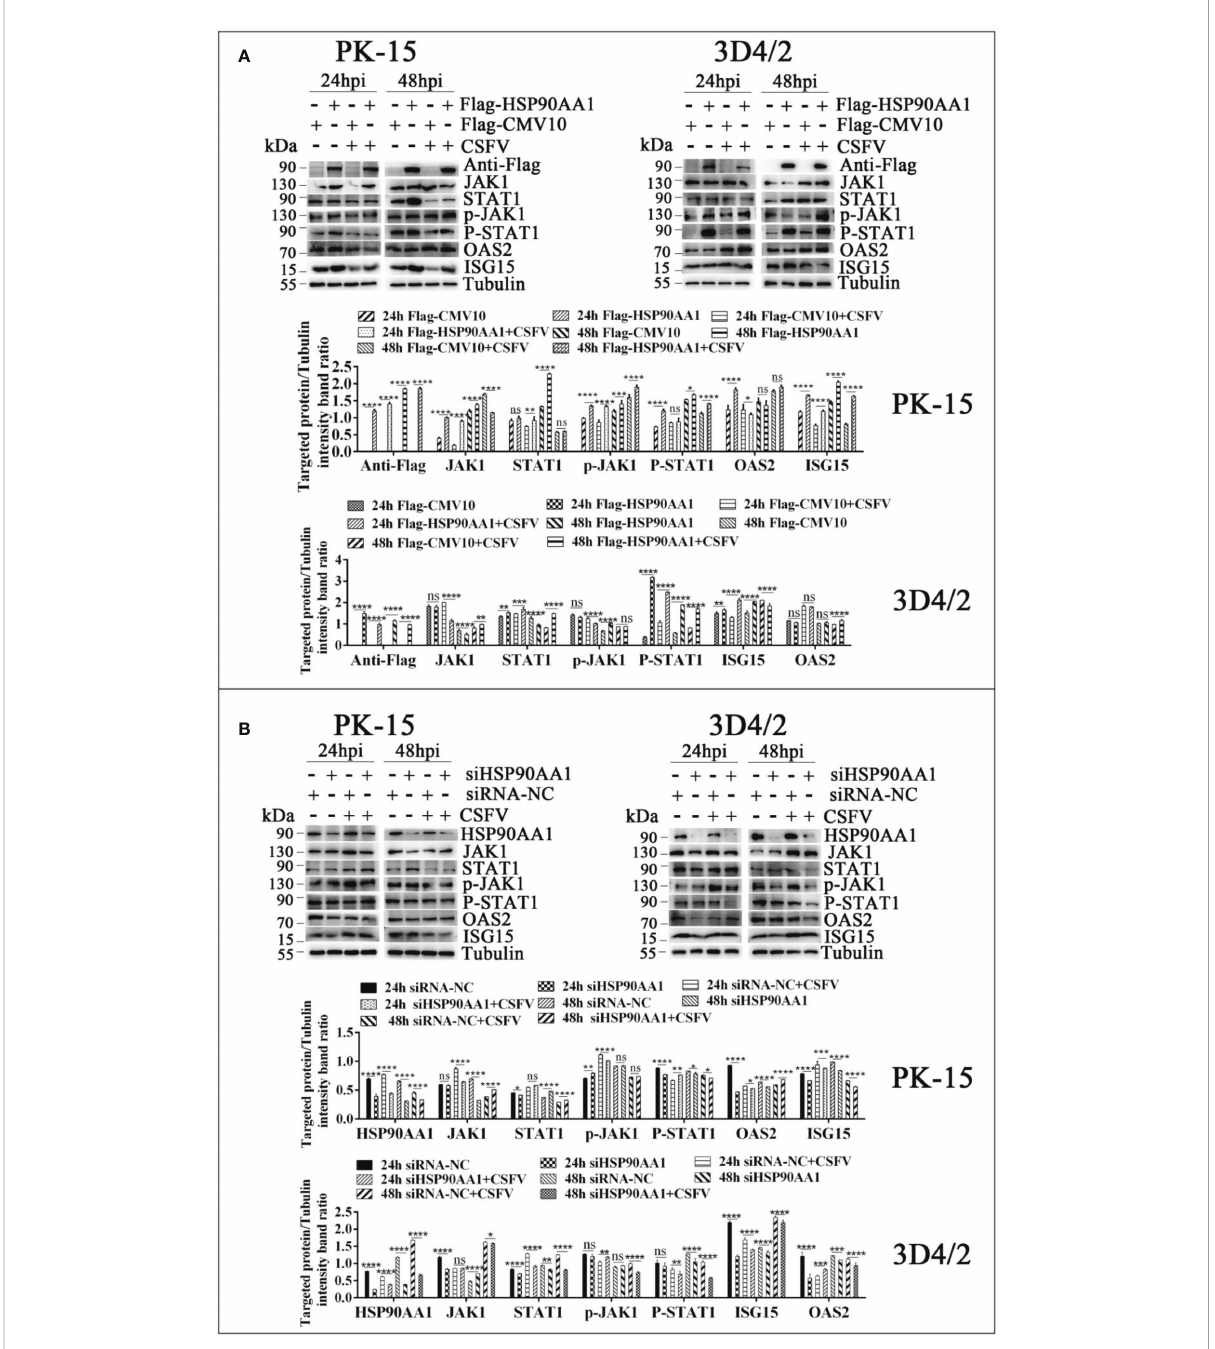
FIGURE 8 CSFV infection antagonizes the activation of HSP90AA1 on JAK/STAT pathway. (A, B) Western blot for JAK1, STAT1, p-JAK1, p-STAT1, OAS2, ISG-15 and HSP90AA1 expression in HSP90AA1-overexpression or knock-downed PK-15 and 3D4/2 cells. Cells were infected with CSFV (MOI=1) after transfection p3×Flag-HSP90AA1 or siHSP90AA1. The cells were not infected with CSFV as a control. Cells were harvested at 24hpi and 48hpi served to Western blot. The relative levels of proteins were estimated by histograms representing density reading of the gel bands with Image J, and the ratios were calculated relative to tubulin control. (*p < 0.05, **p < 0.01, ***p < 0.001 and ****p < 0.0001 calculated using two-way ANOVA, ns, not signi fi